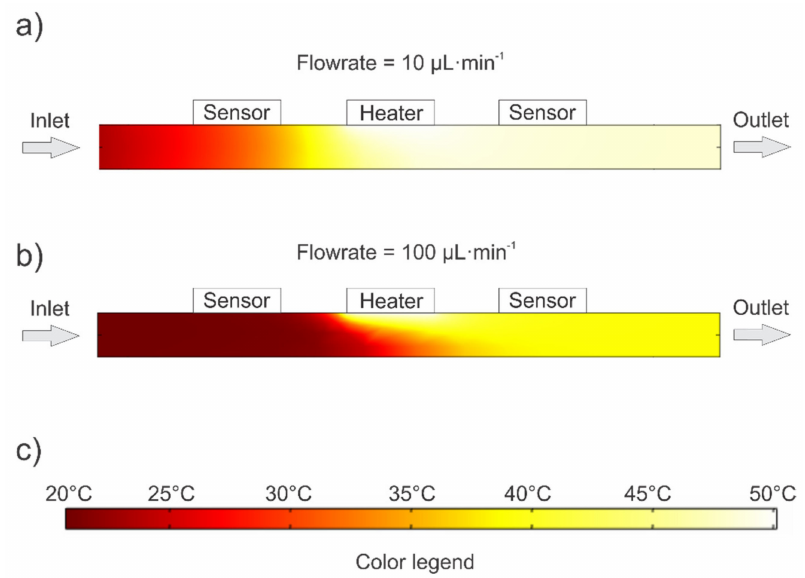
Figure 10. A simulated temperature distribution in a cross section along the 1000 µ m deep channel ( a ) for flowrate of 10 µ L · min − 1 and ( b ) for flowrate of 100 µ L · min − 1 . Color legend ( c ) is the same for both case